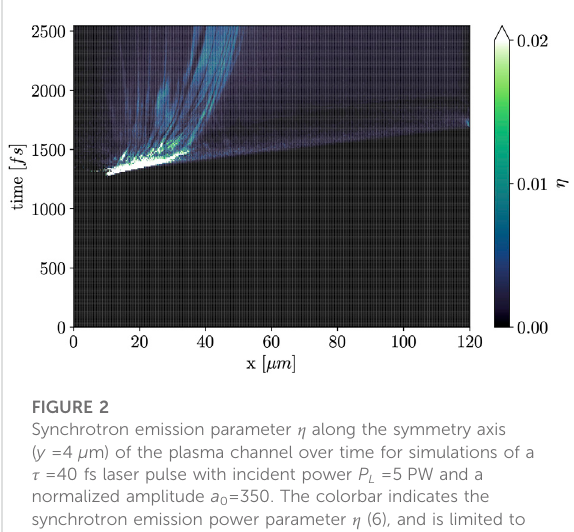
FIGURE 3 Angulardistributionofthephotonenergyspectrumindegree with respect to the channel ’ s symmetric axis in MeV for a simulation with a laser pulse P L =5 PW, τ =40 fs, and a 0 =350, hitting a cylindrical target of C 6+ plasma, averaged over the duration of the simulation. The dotted blue line indicates the beams de fi ned as the emission cone at Φ =±45 ° ±10 °